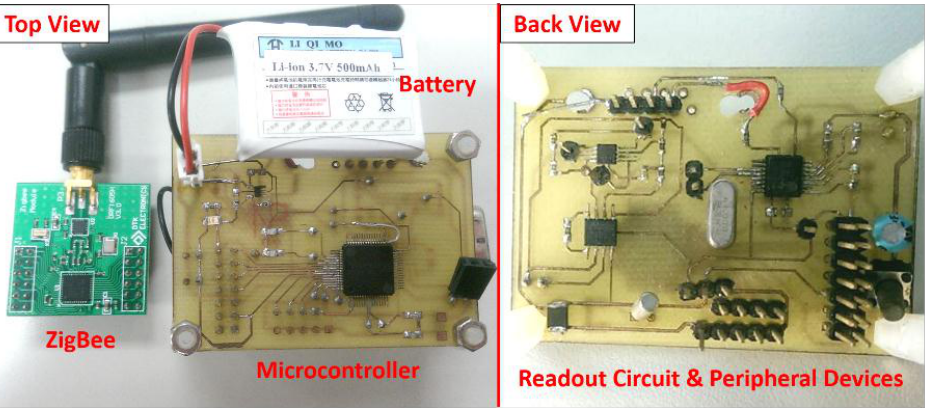
Figure 8. Realization of the proposed system device.